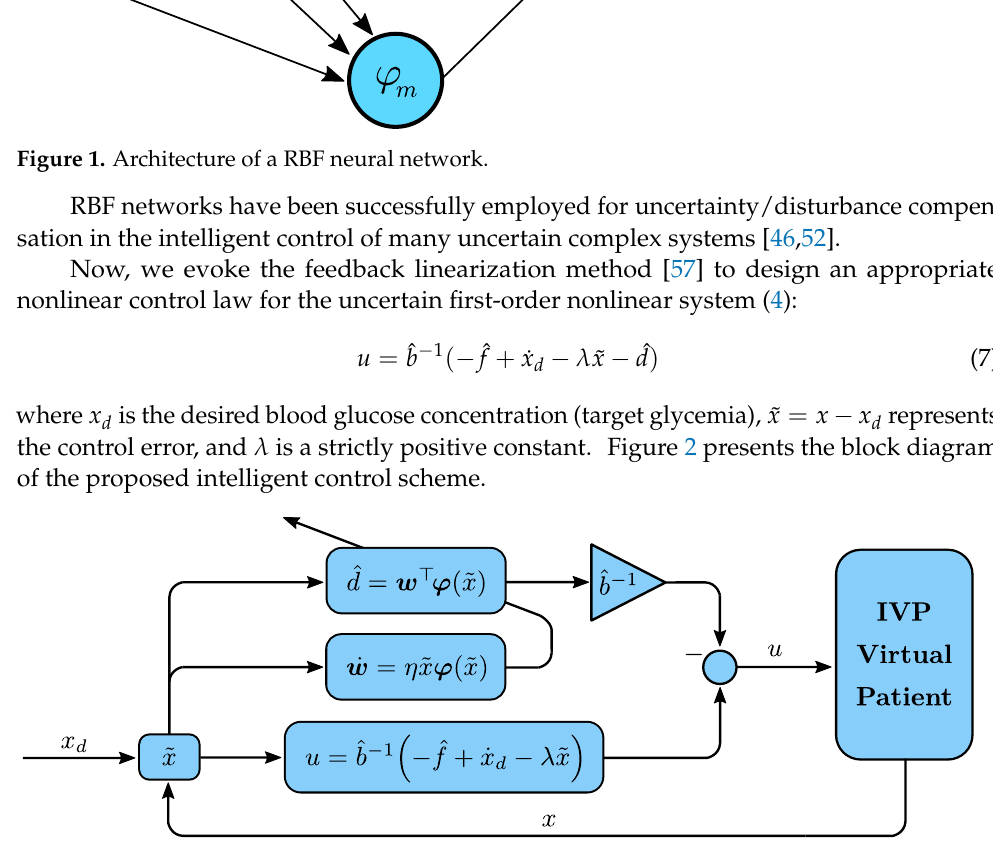
Figure 2. Block diagram of the proposed intelligent